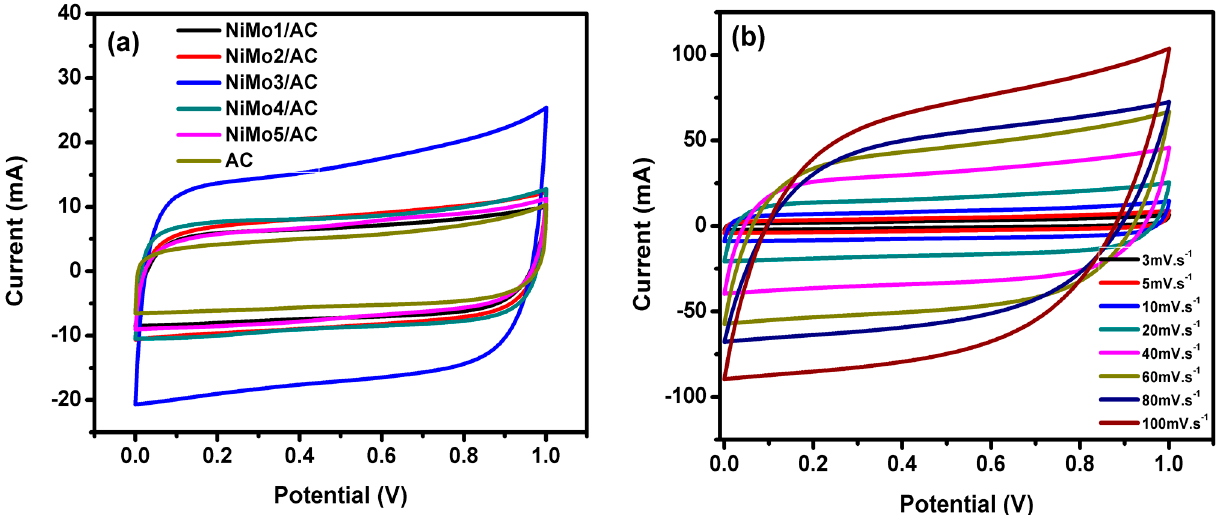
Figure 9. CV curves of ( a ) AC, NiMo1/AC, NiMo2/AC, NiMo3/AC, NiMo4/AC, and NiMo5/AC at a scan rate of 20 mV/s, and ( b ) NiMo3/AC at different scan rates. Table 3. The specific capacitance values are derived from CV and GCD. Capacitance retention RCs after 4000 cycles at 4 A g –1 . EIS is used to calculate the equivalent series resistance